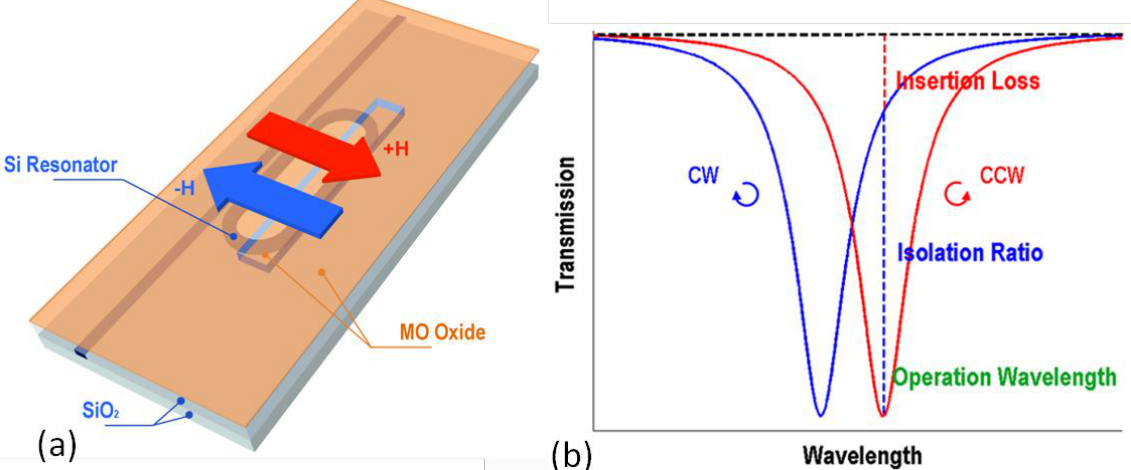
Figure 9. ( a ) Sketch of a patterned nonreciprocal optical resonator; ( b ) Transmission spectrum of clockwise (CW, forward) and counter-clockwise (CCW, backward) propagating light through the resonator device. Optical isolation is achieved around the CCW resonance wavelength [105]. (Reprinted with permission from [105]. Copyright